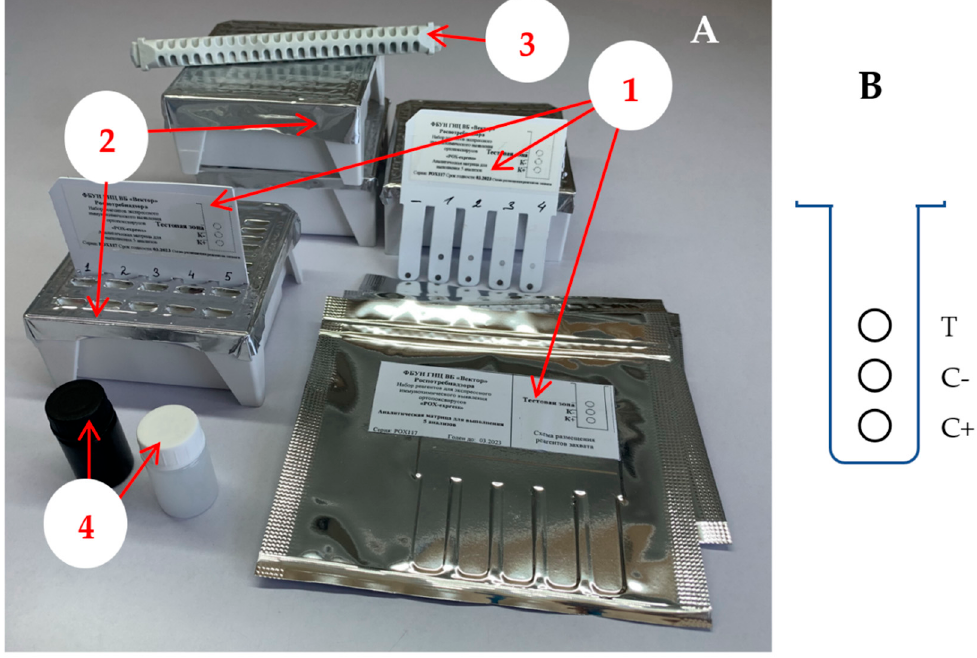
Figure 1. Design of a kit for dot-immunoassay of orthopoxviruses. (the A )-the basic elements of the kit for detection of orthopoxviruses: 1-protein arrays, 2-analytical baths, 3-perforator, 4-liquid components of the developing system. ( B )-the scheme of capture reagents immobilization on the protein array: T-test zone (a/POX-IgG 1:100), C − -negative control (IgG RNS 1:100) and C+-positive control (VACV (LIVP) 10 5 PFU/mL).